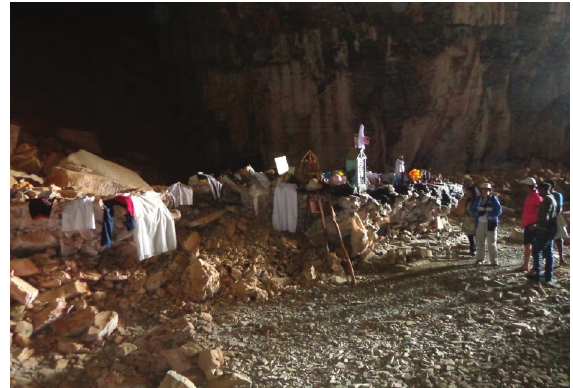
Figure 2 - Photo of religious offerings, remains of molten candle and soot in “Lapa dos Brejões” Cave, Chapada Diamantina, Bahia, Brazil (Photo: Rafael Albani,